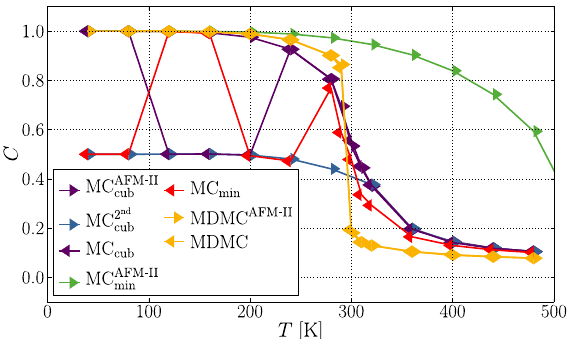
Fig. 4 Temperature dependence of the order parameter. Order parameter C as a function of the temperature T obtained in different simulation methods for 6 × 6 × 6 MnO supercells. The superscript of the simulation method de fi nes the initial magnetic con fi guration (cubic AFM-II or second global minimum), otherwise random initial magnetic orders are used. The subscript cub indicates the restriction to the cubic lattice with a exp ¼ 4 : 430 Å and the subscript min indicates an optimization of the initial structure prior to the MC simulation. Lines are only drawn to guide the eyes.